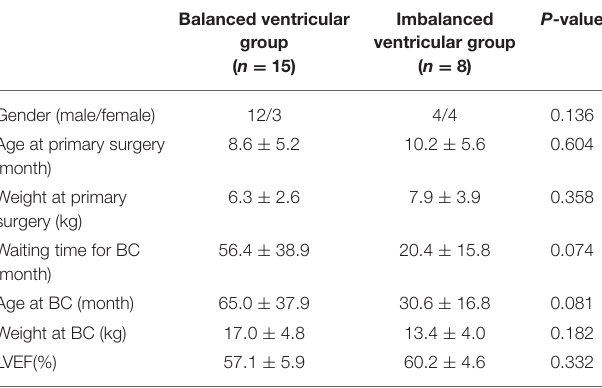
TABLE 1 | Baseline characteristics stratified by different